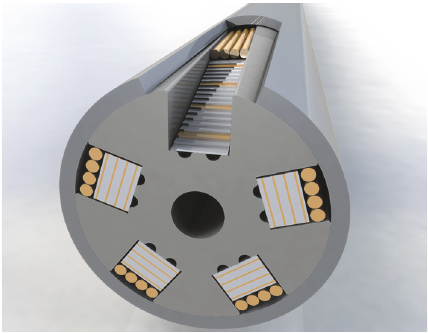
Figure 1: Artistic view of the assembled ENEA HTS 2G wire-based